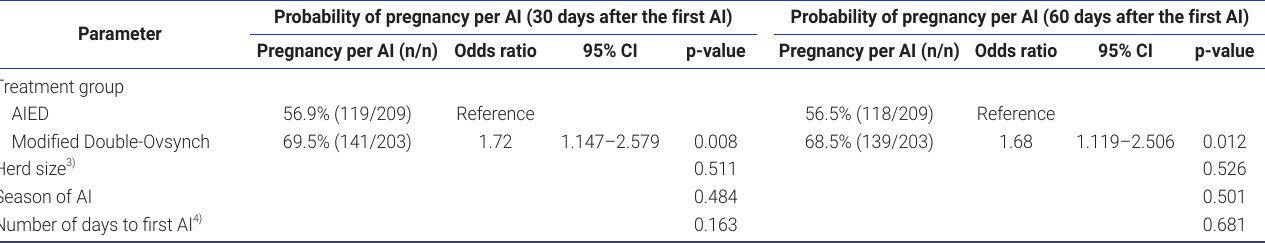
Table 1. Factors affecting pregnancy per AI on the 30 and 60 days after the first AI in the modified Double-Ovsynch 1) and AIED 2) groups, identified using a logistic regression model